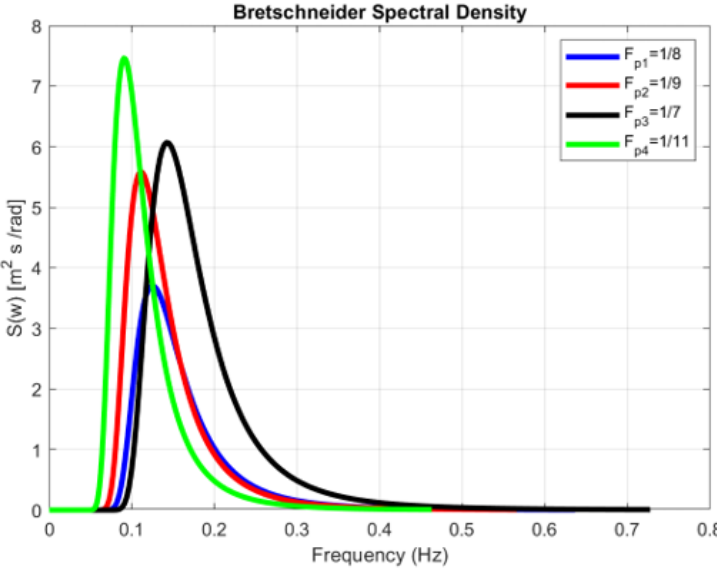
Figure 18. Bretschneider spectral density for all sea states.